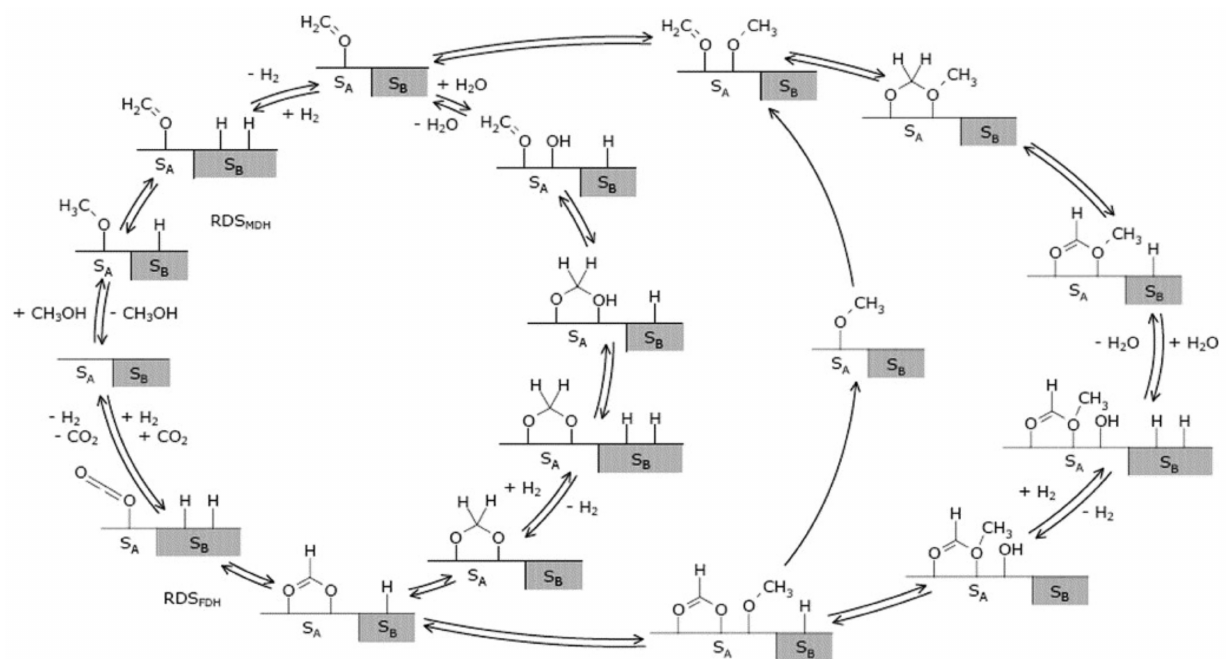
Figure 10. The proposed catalytic cycle of SRM reaction, including different kind of active surface sites: S A and S B . (Adapted from [81], copyright 2007,